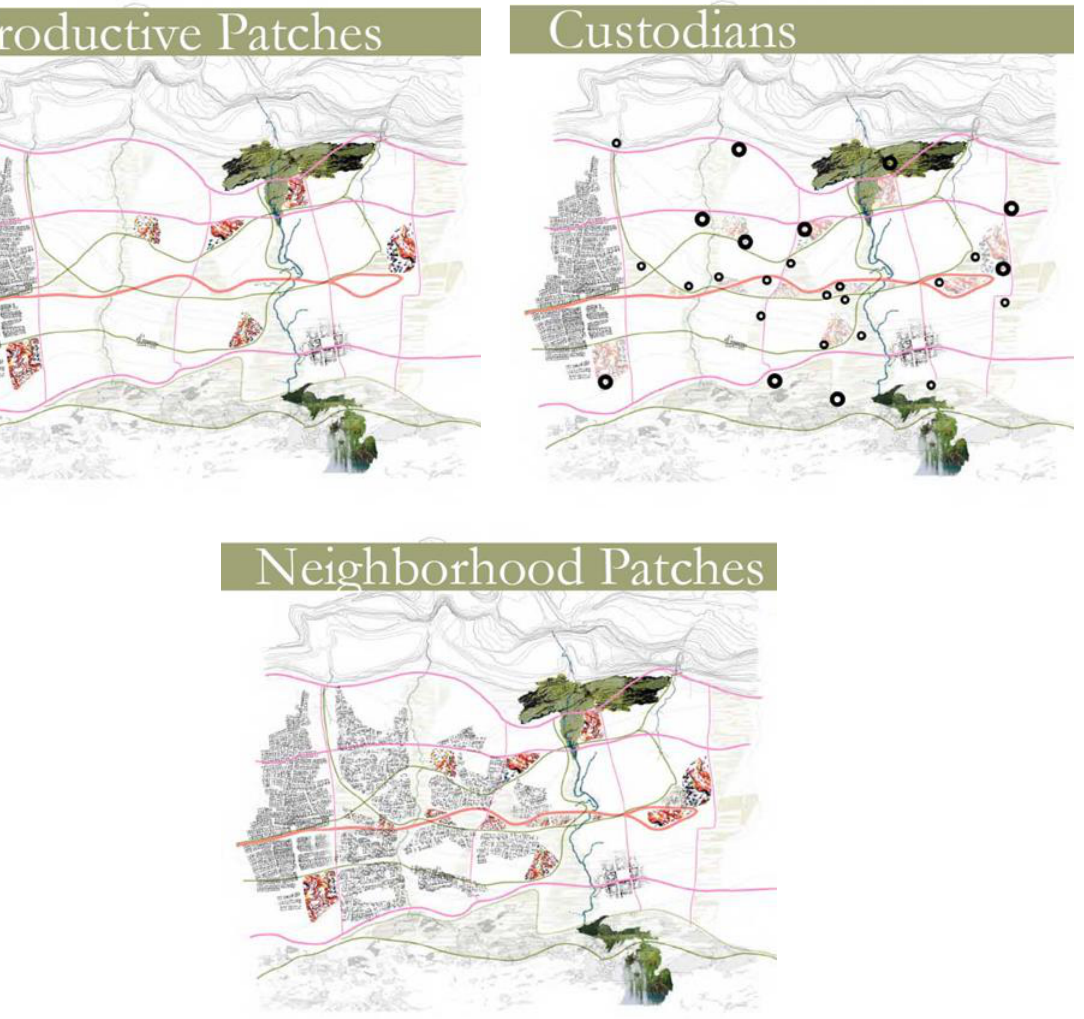
Figure 2. Informal Armature © David Gouverneur. Protectors/Buffers —Parks, Environmental Protection, Control of Expansion, Water and Waste Management, Agriculture/Grassing, Passive Amenities, Recreation. Attractors —Initial Provision of Water, Energy, Food, Materials, Security, Sanitation, Transportation, and Recreation. Productive Patches —Separators, Recycling/Construction Sites, Waste Management, Manufacturing, Real-Estate Operations, Metropolitan Services, Sports, Mixed-use Packages. Custodians —Stewardship of Public Turf, Icons, Managerial Centers, Information, Governance “The Garden Keepers”. Neighborhood Patches —Subject to Squatting, Pirate Development, Site and Services Program, Mixed Formal/Informal Operations, Local Centralities and Connectors.